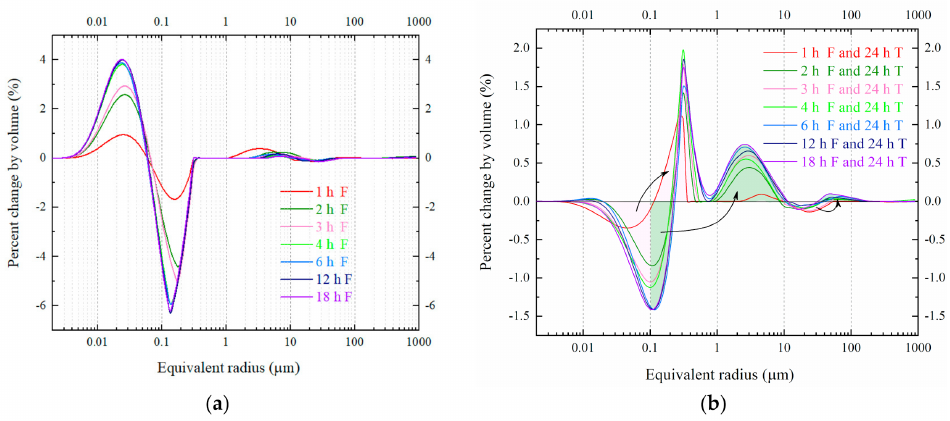
Figure 14. PSD changes after different freezing durations: ( a , b ) show the post-test results changes to pore distribution initially and after a 24 h rest